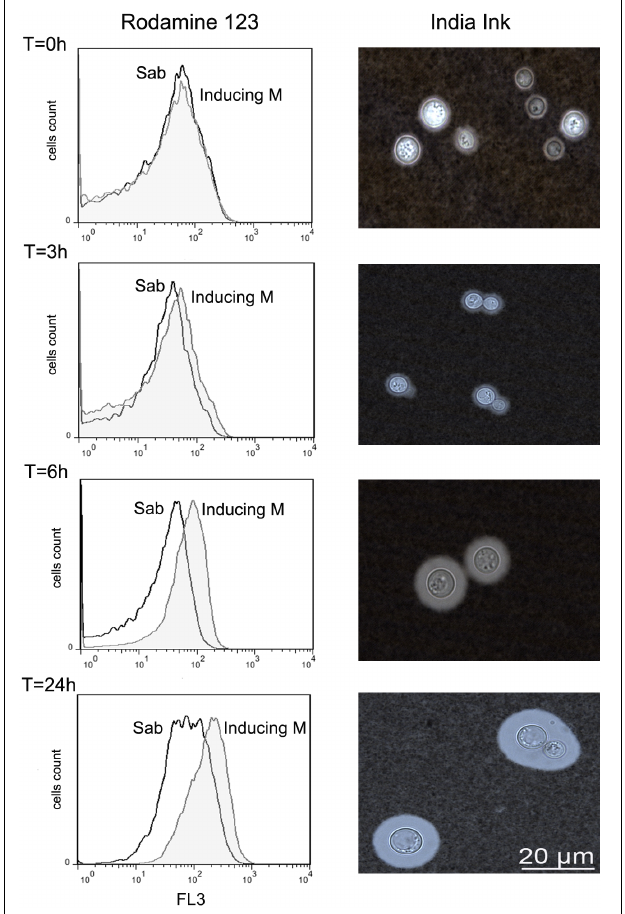
FIGURE 4 | Evaluation of mitochondrial membrane potential during capsular growth. Cells from H99 strain were incubated in capsule induction medium or Sabouraud for 0, 3, 6, and 24 h, and after each time, rhodamine 123 was added (see Materials and Methods). The uptake of this probe was analyzed by flow cytometry (left panel). The graph represents the results of a representative experiment, which was performed three different times. Cells in Sabouraud (Sab) are represented with histograms in black line and the cells in capsule inducing medium (MOPS) are represented in gray histograms. Representative cells from each time in the capsule inducing medium are shown in the right panels.